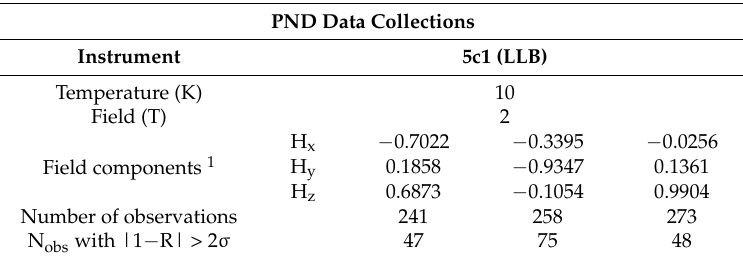
Table 1. Details of the PND data collections.